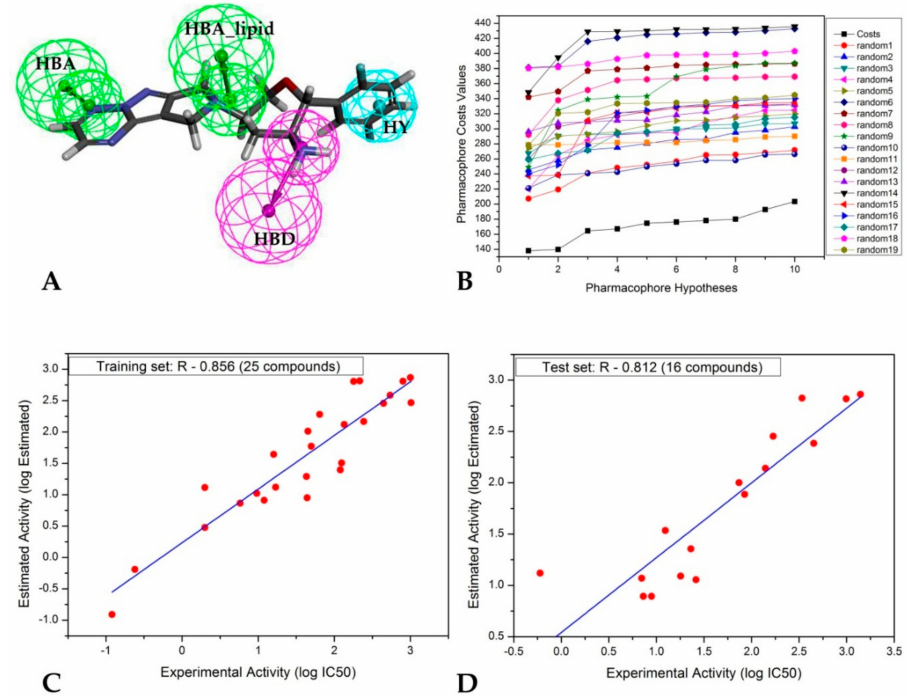
Figure 1. Graphical representation of pharmacophore data. ( A ) The top scoring Hypo1 is mapped to the most active compound in the training set (DPP4_1) (HBA, hydrogen bond acceptor; HBA_lipid, hydrogen bond acceptor lipid; HBD, hydrogen bond donor; HY, hydrophobic). ( B ) Fischer validation: The total cost of the initial and the 19 random spreadsheets on the 95% confidence level. ( C ) Correlation between the experimental and predicted activity (pIC 50 ) by Hypo1 for the training set compounds. ( D ) Correlation between the experimental and predicted activity (pIC 50 ) by Hypo1 for the test set